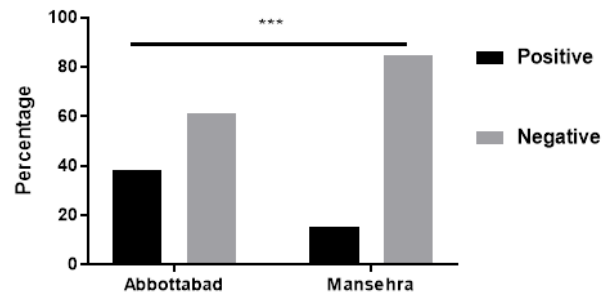
Figure 1. Seroprevalence of toxoplasmosis in different districts. Out of the total of participants in every district, 38.7% (79/204) had